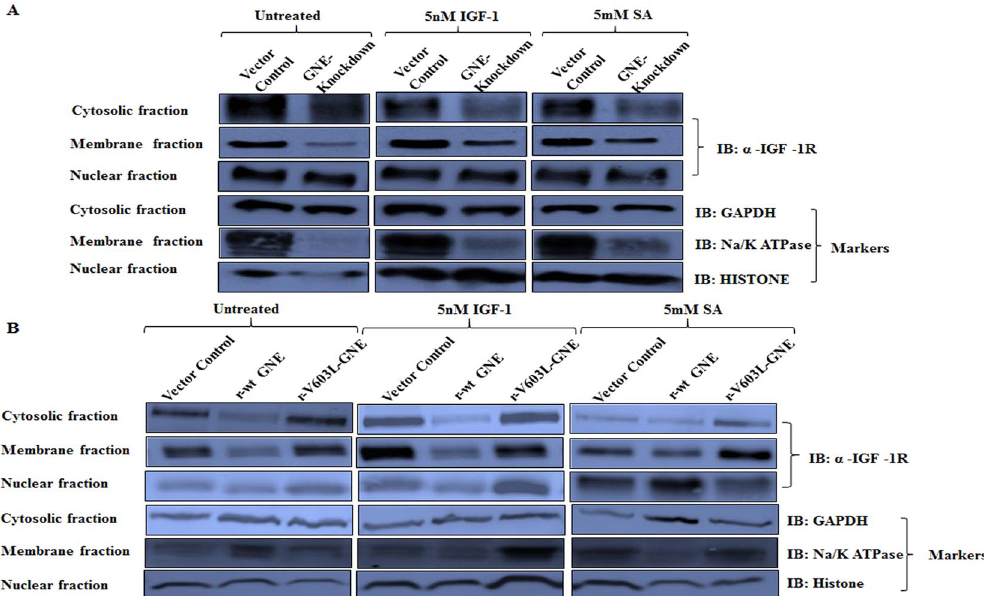
Figure 3. Localization of IGF-1R by sub-cellular fractionation: Membrane, nuclear and cytoplasmic fractions from different cell lines were obtained as described in Material & Methods. ( A ) Distribution of IGF-1R in various fractions of GNE knockdown cells and ( B ) GNE mutant cells is shown compared to vector control. The cells were untreated, IGF-1 treated or Sialic acid (5 mM SA) supplemented as described in Methods. Immunoblotting was done with anti- α IGF-1R antibody, anti-GAPDH (cytosolic marker), anti-Na/K ATPase (membrane marker) and anti-Histone H3 (nuclear